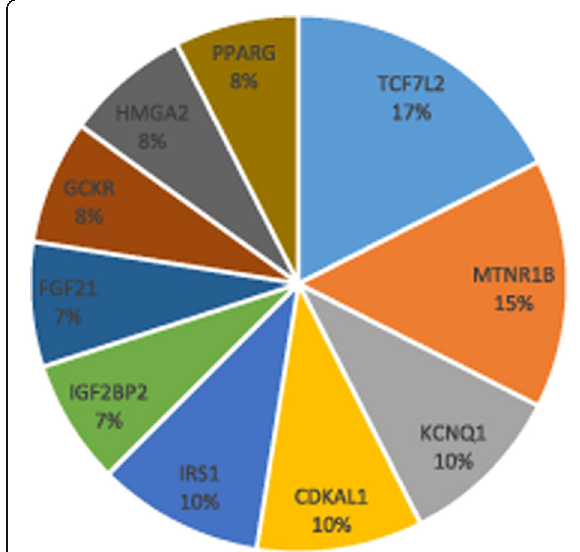
Fig. 2 Percentage prevalence of most implicated GDM genes from data